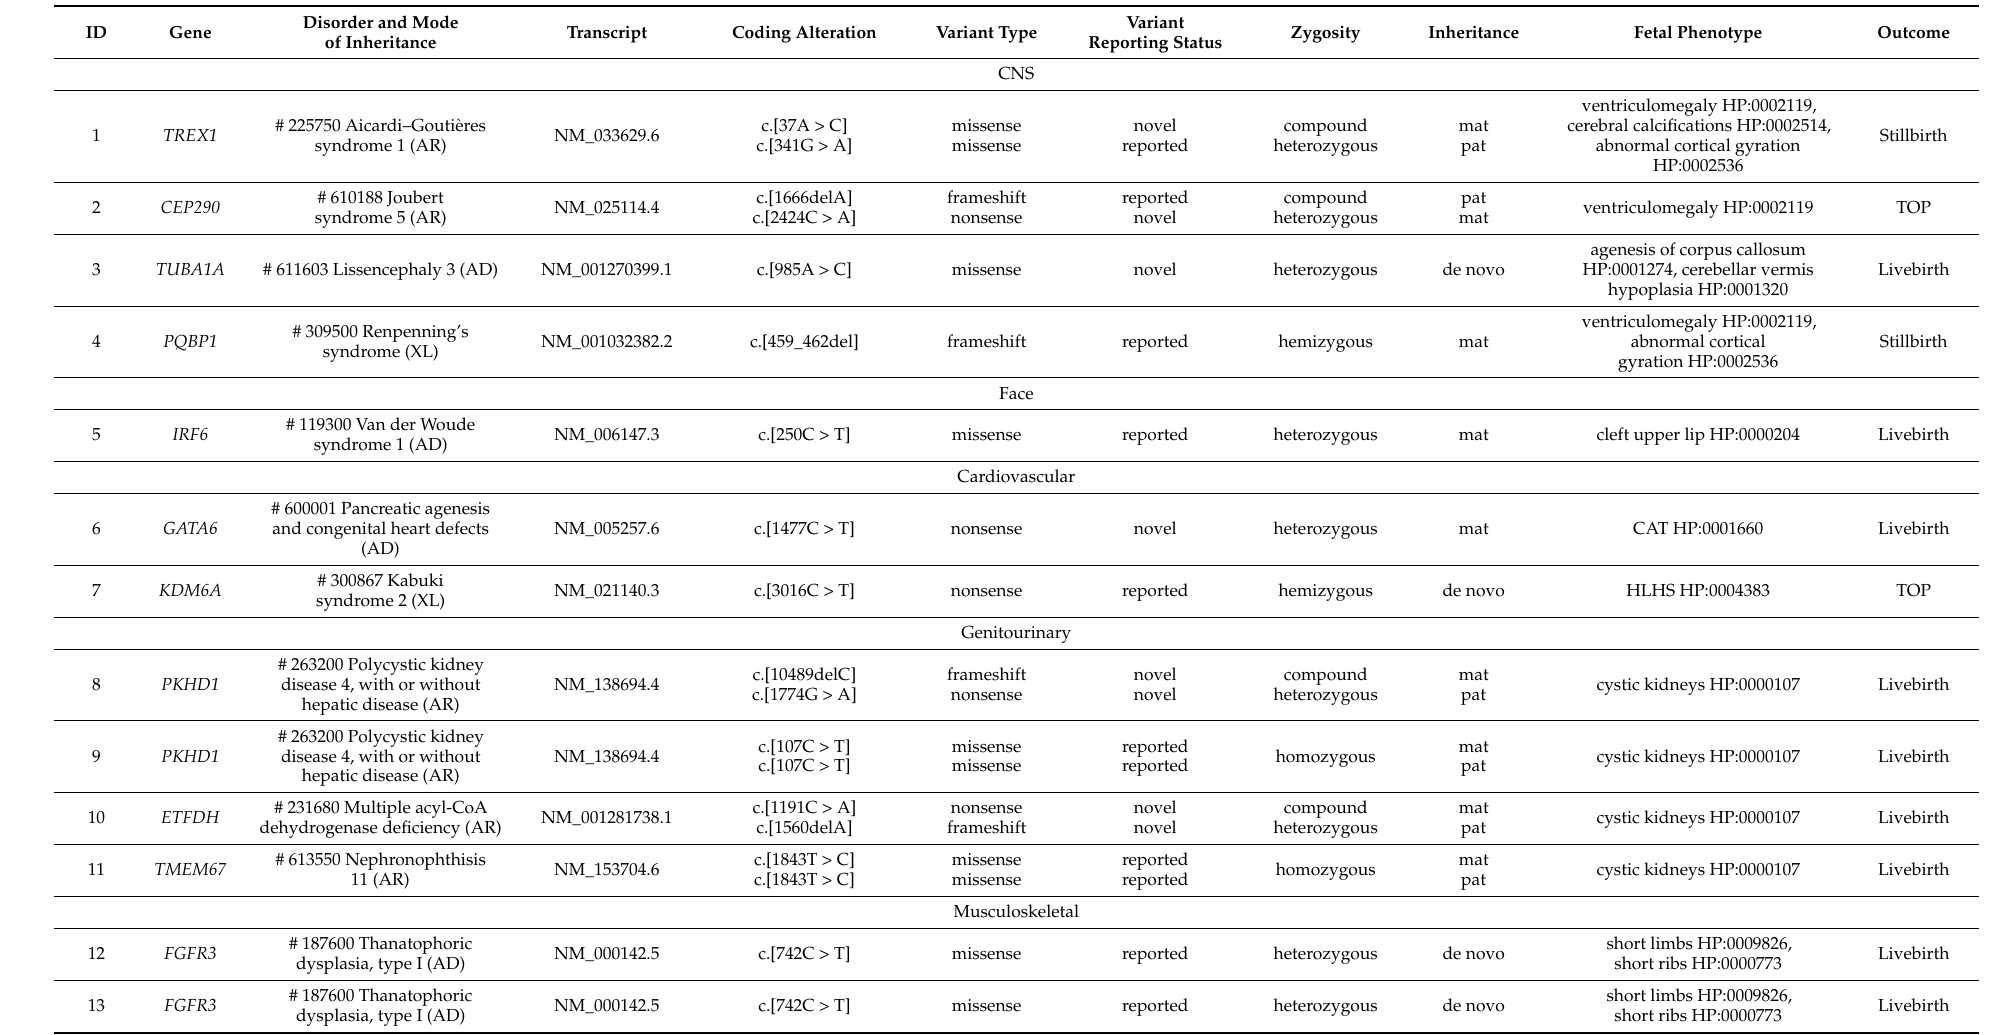
Table 2. Sonographic findings in fetuses with abnormal exome sequencing—detailed